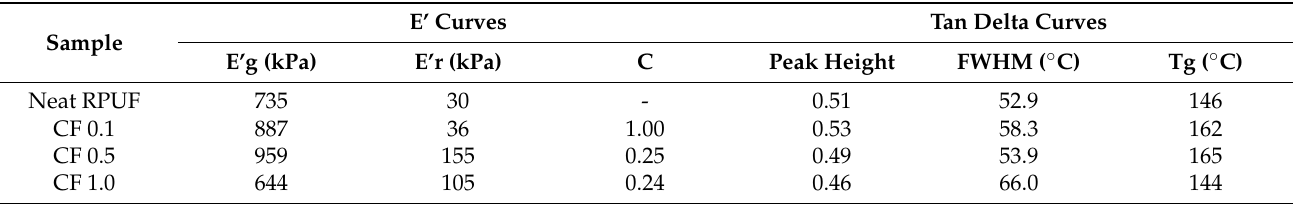
Table 4. Compilation of results from the DMA curves (Figure